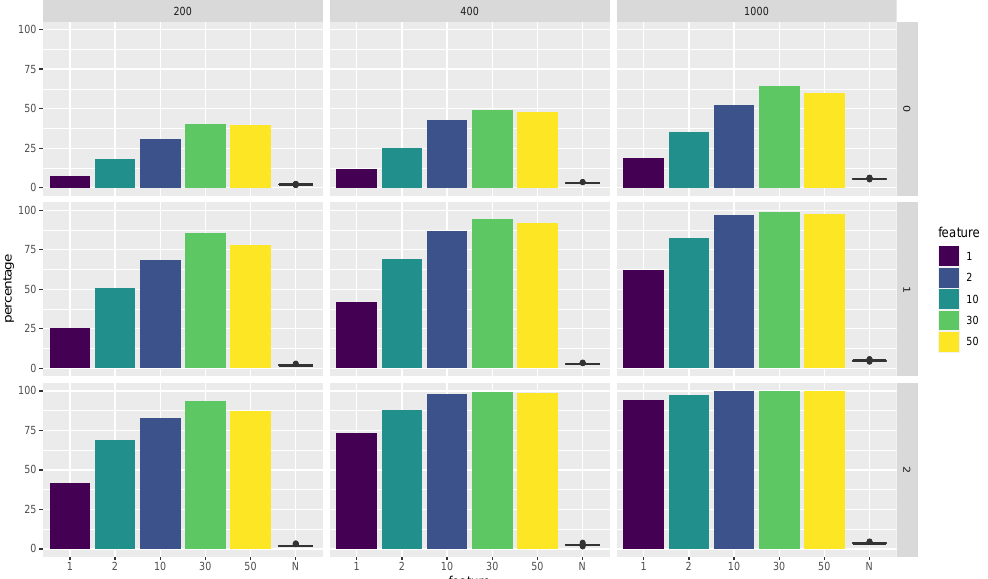
Figure 4. The average selected proportion for each feature for different sample size (corresponding to each column) and iteration number (corresponding to each row) in Model 2